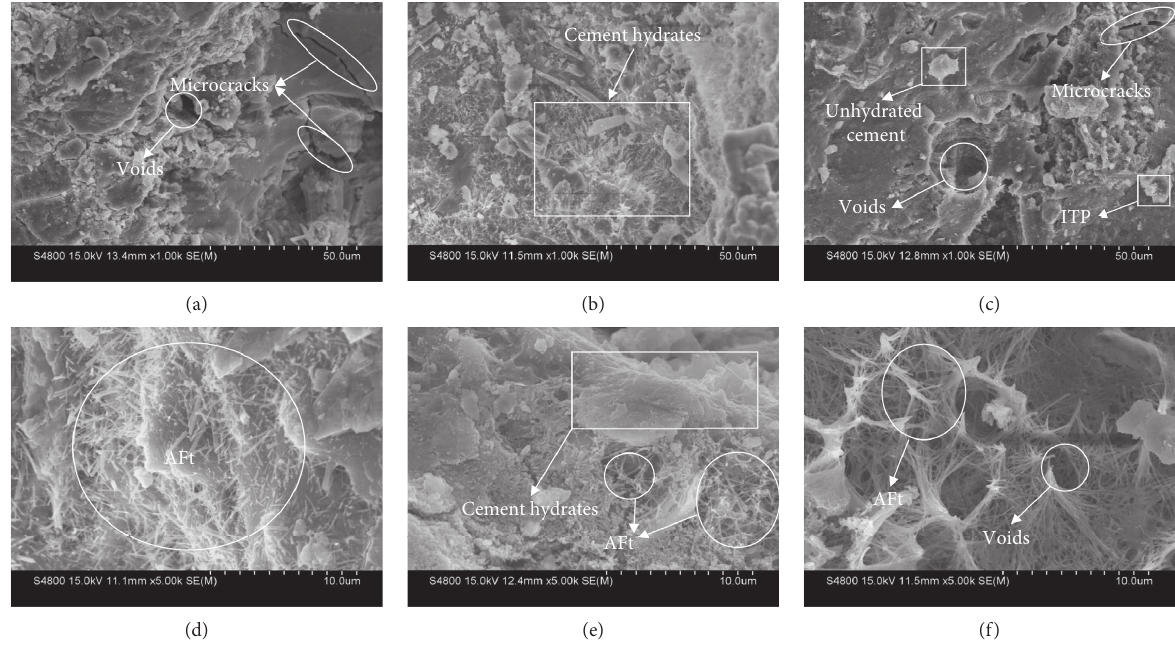
Figure 8: Microstructure of concrete: (a) sample CIP0, (b) CIP15, and (c) CIP30 with magnification of × 1,000; (d) sample CIP0, (e) CIP15, and (f) CIP30 with magnification of ×